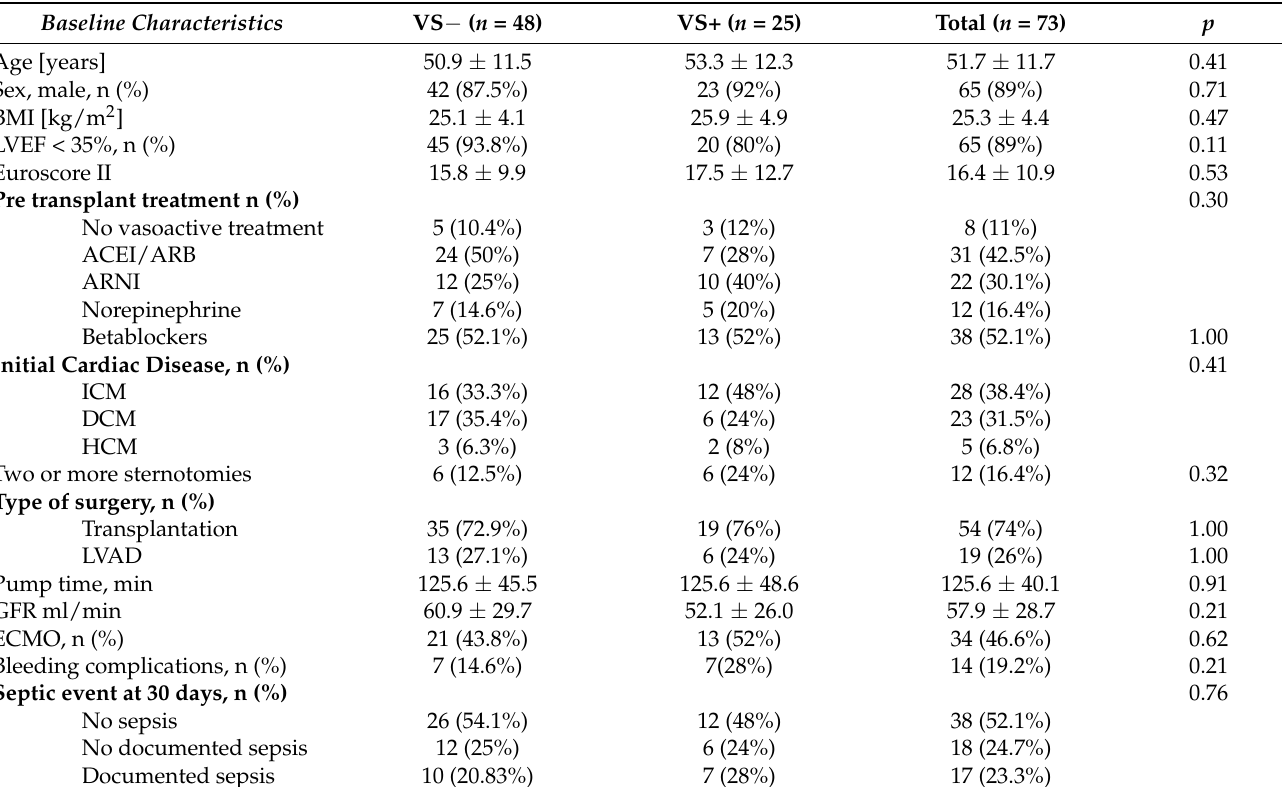
Table 1. Baseline Characteristics of the Whole Study Population and patients with (VS+) and without (VS − )